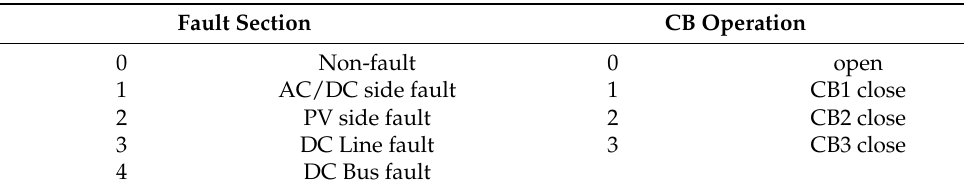
Table 3. Meanings of the fault sections and CB operations.